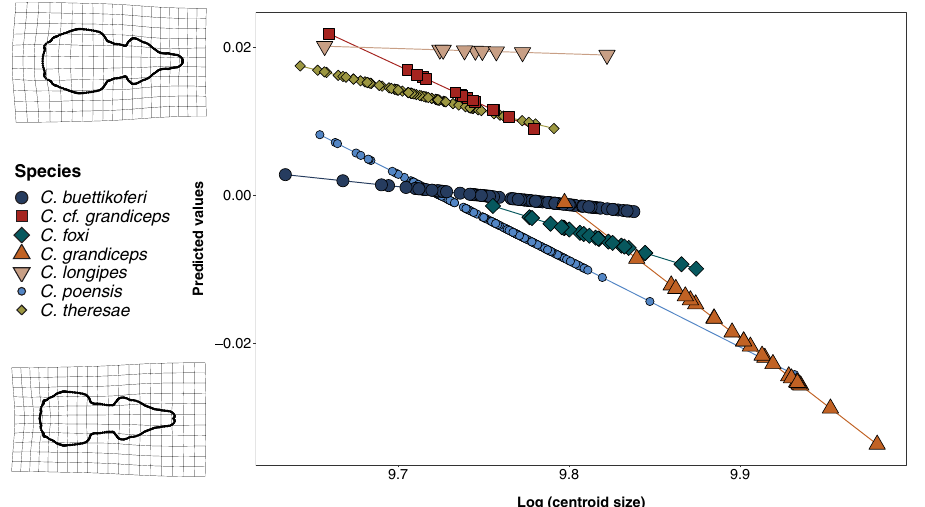
Figure 4. Allometric slopes of the C. poensis species complex (only species with a specimen count ≥ 9 are shown). Prediction lines representing predicted shape plotted against log centroid size with species grouping. Only species for which N ≥ 9 are shown. Deformation grids depict the shapes associated with the larger and smaller specimens, relative to the mean, with a magnification of 3. Species are labelled according to colors and symbols.